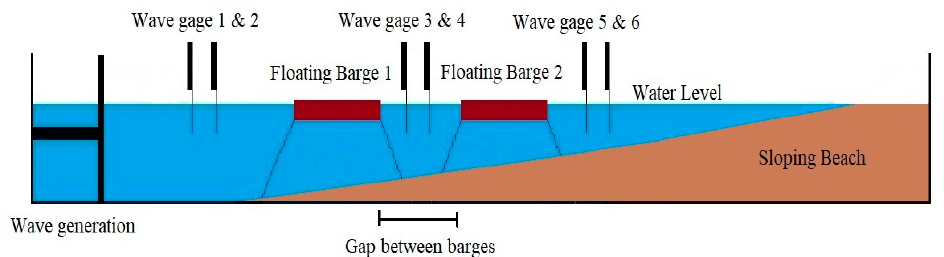
Figure 10. Schematic diagram of an experimental setup in a wave flume.